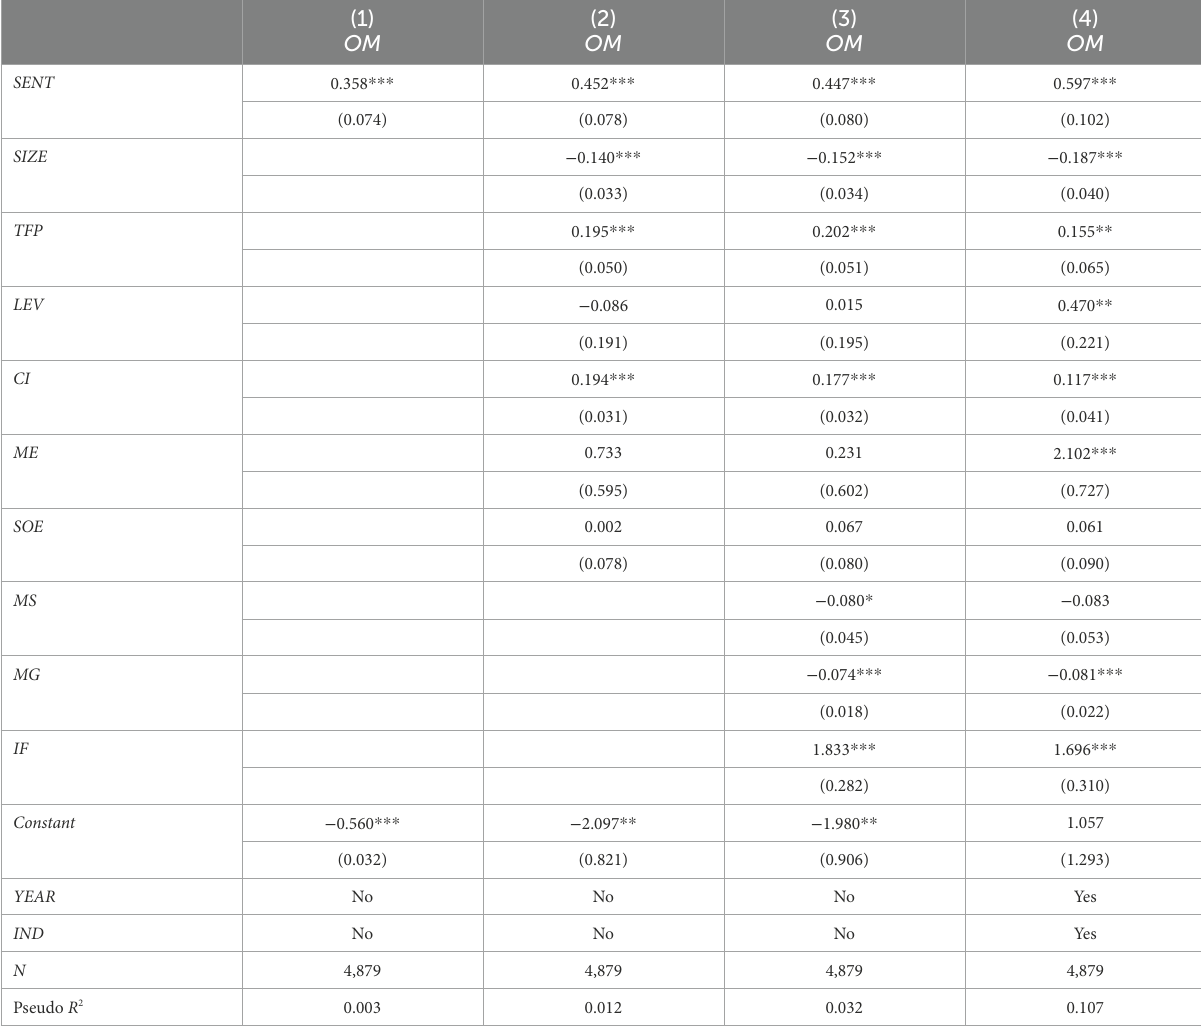
TABLE 4 Investor sentiment and foreign establishment